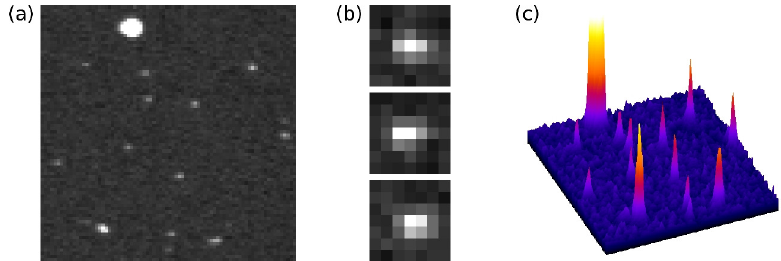
Figure 2. ( a ) 80 × 80 pixel area of a frame with single photon events as detected with a Hamamatsu electron-bombarded CCD at 8 kV acceleration voltage and maximum read-out gain. A bright, large ion event can be seen near the top edge; ( b ) Enlarged areas of three photon events; ( c ) 3D representation of the area in ( a ).